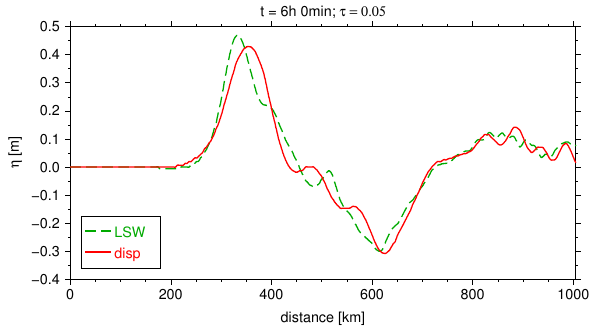
Fig. 8. The linear hydrostatic and linear dispersive solutions of the Indian Ocean tsunami towards Africa extracted along a transect with length 1000km (surface elevations). Waves are propagating to the left.